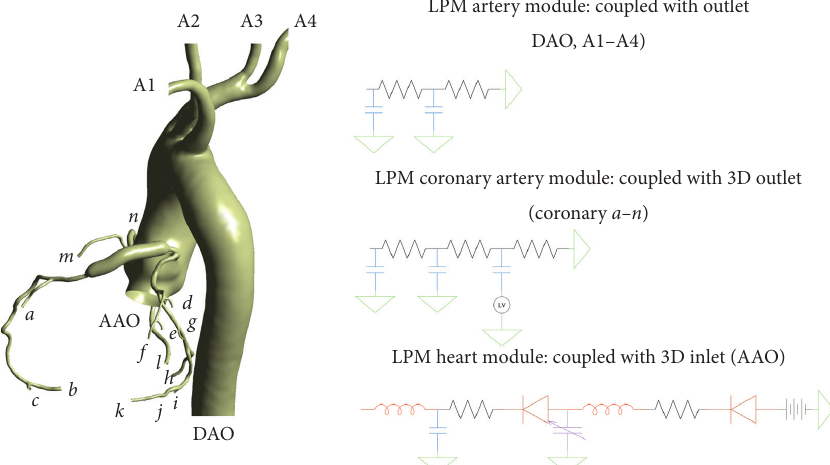
Figure 3: Details of the multiscale model used in the study, showing the coupled interface between the lumped parameter model (LPM) and the three-dimensional model. an , coronary arteries; A1A4, arteries; AAO, ascending aorta; DAO, descending aorta; RCR,